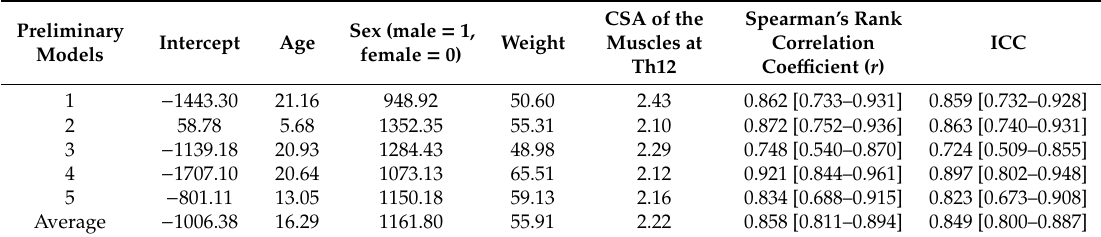
Table 2. Several prediction models in a five-fold cross validation.